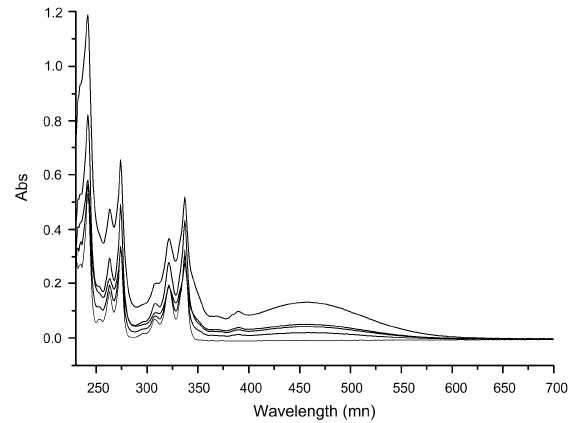
Figure 9. Enhancement in the intensity of the absorption of pyrene with increasing concentration of Ti3 from 0 to 24 × 10 − 7 M at 25 °C.